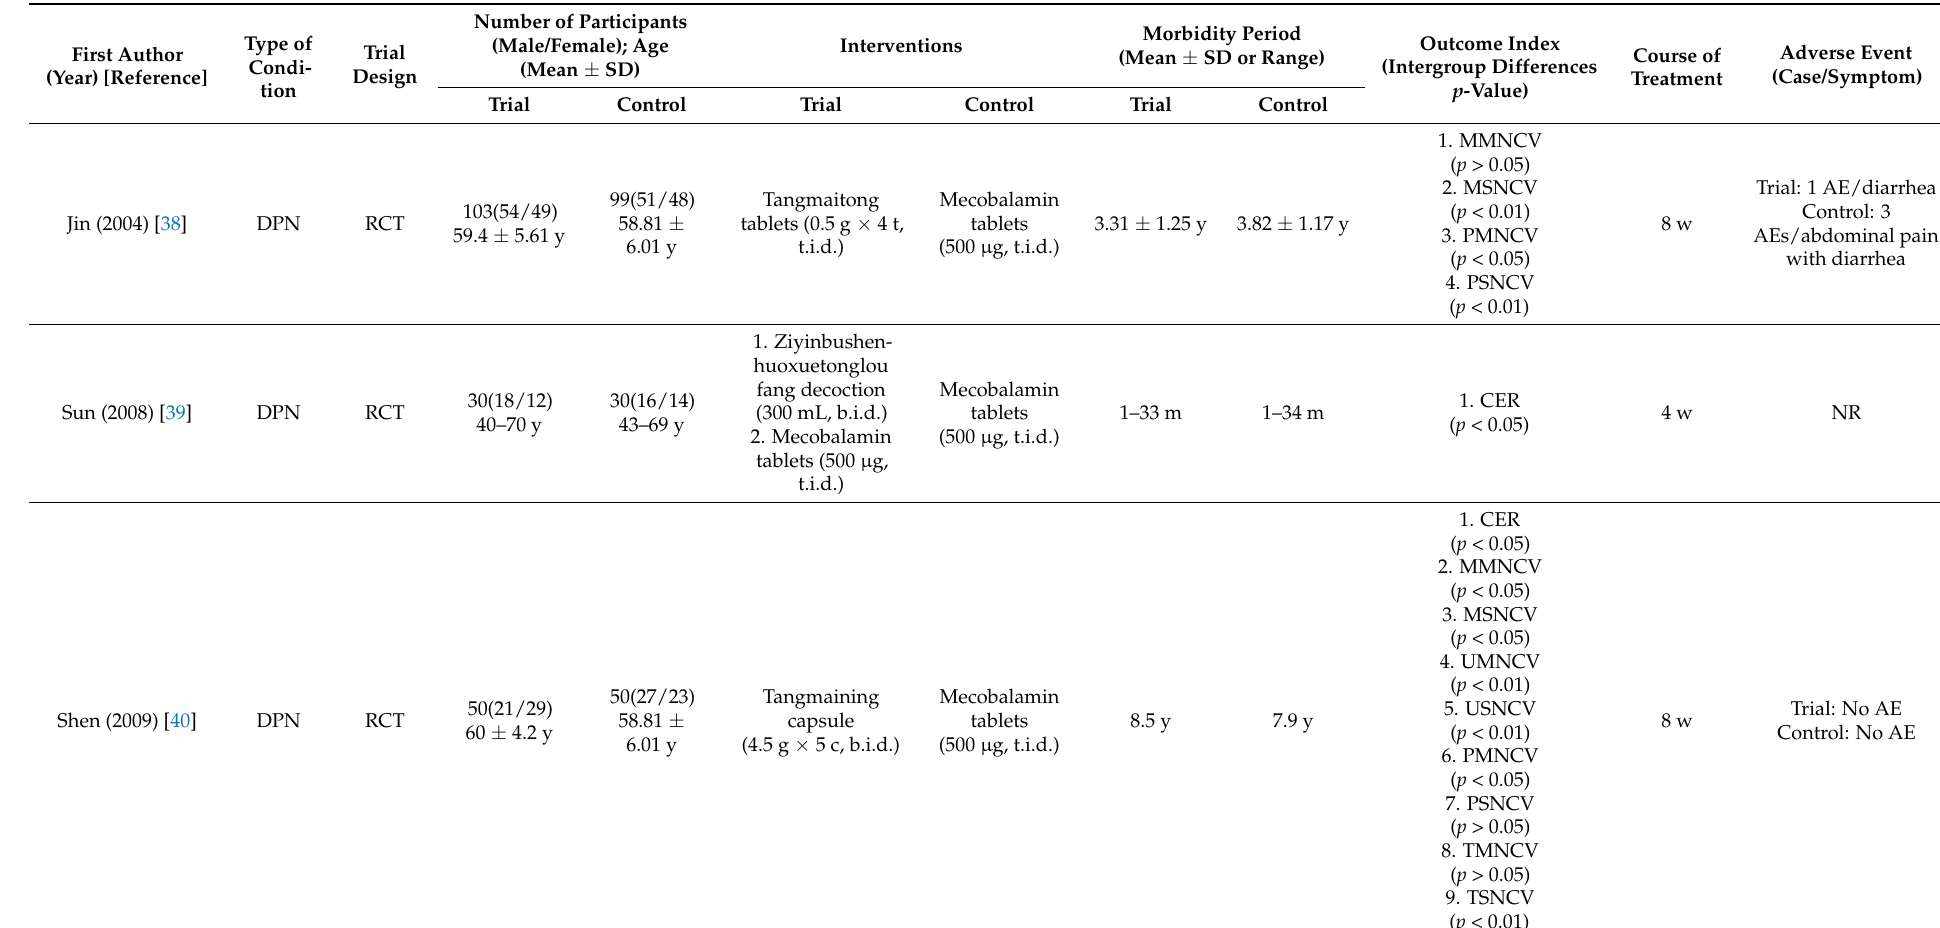
Table 1. Characteristics of the included